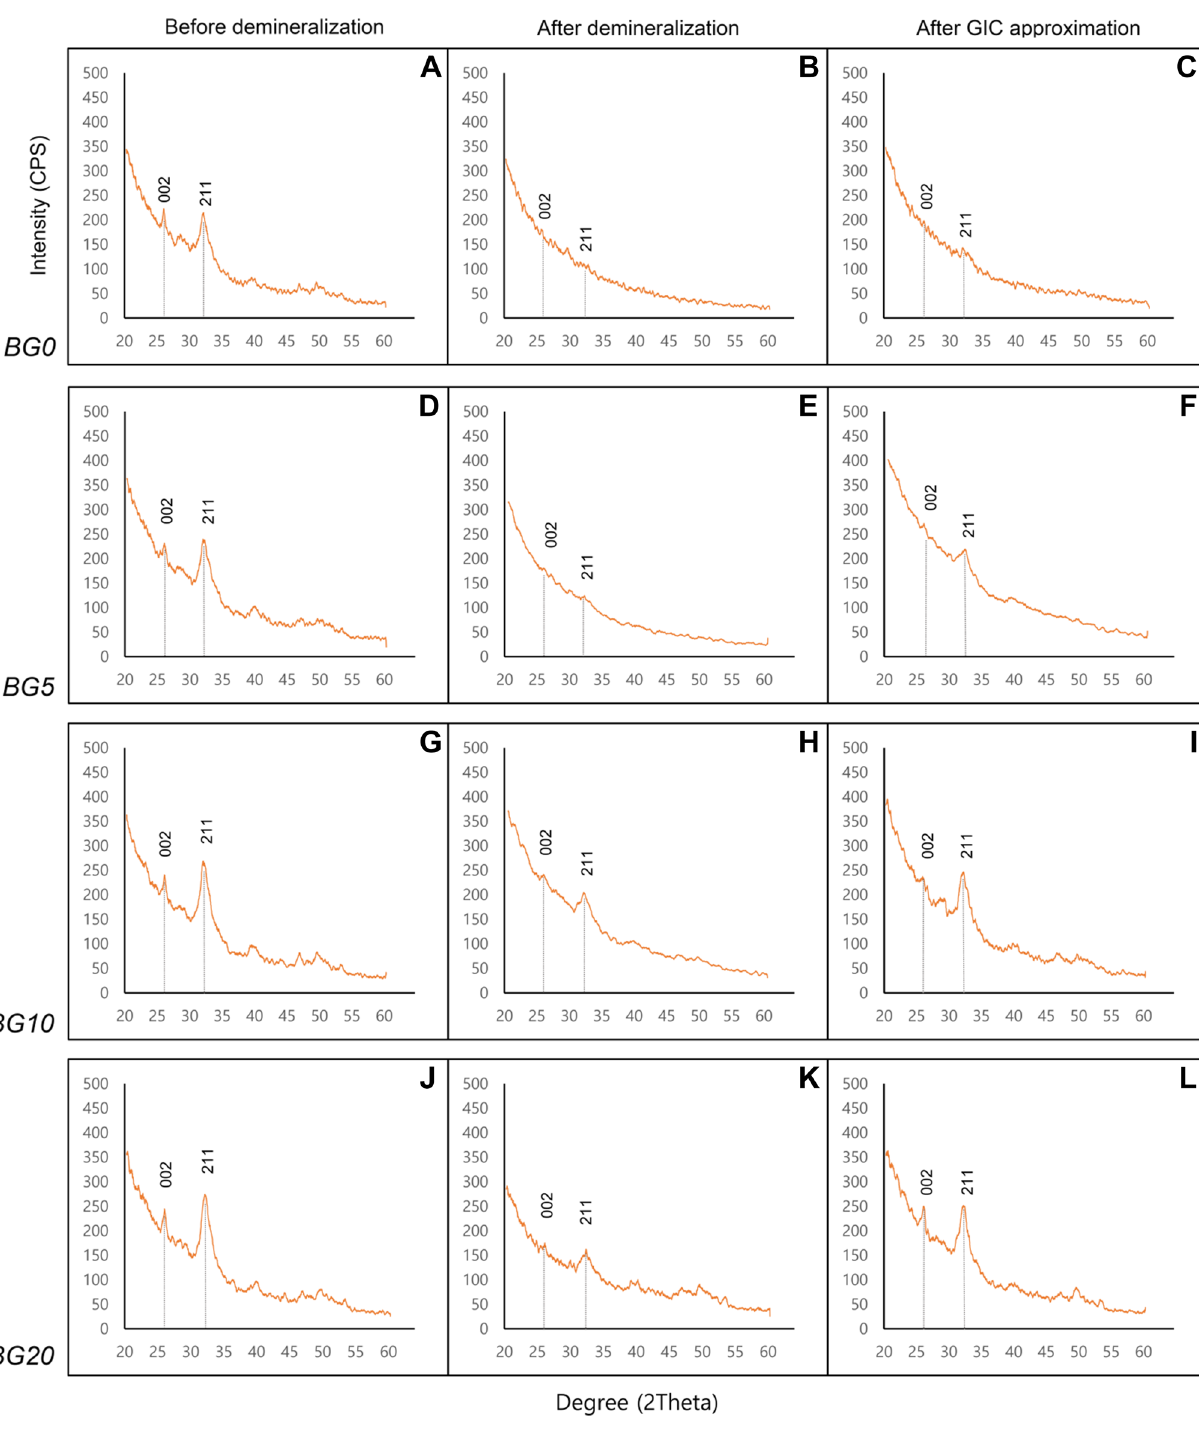
Figure 3. Representative XRD graph of dentin surface. ( A – C ) BG0 group. ( D – F ) BG5 group. ( G – I ) BG10 group. ( J – L ) BG20 group. ( A , D , G , and K are representative of dentin surfaces before demineralization. B , E , H , and K are representative of dentin surfaces after demineralization. C , F , I , and L are representative of dentin surfaces after GIC approximation). The gray dotted line: 26° (002) and 31.8° (211) peak represent fluorapatite (FAP) or hydroxyapatite (HAP)